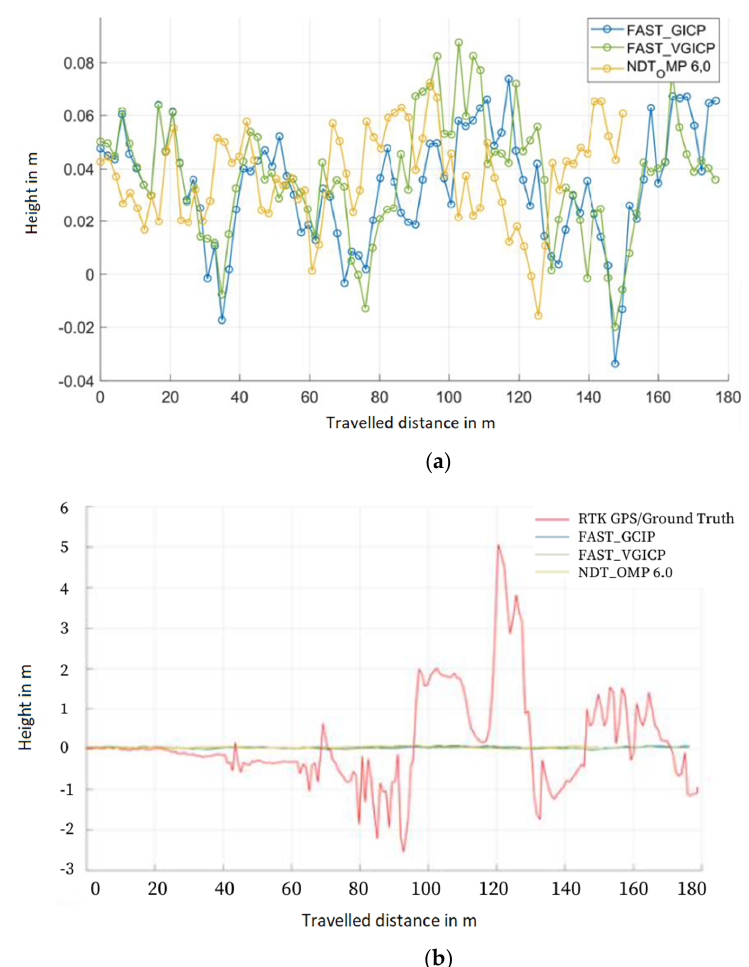
Figure 13. ( a ) Height course of the trajectory of the different scan matching methods (FAST_GICP, FAST_VGICP, and NDT_OMP) on the parking lot of the University of Applied Sciences Offenburg. ( b ) Elevation trajectory of the RTK GPS (red).